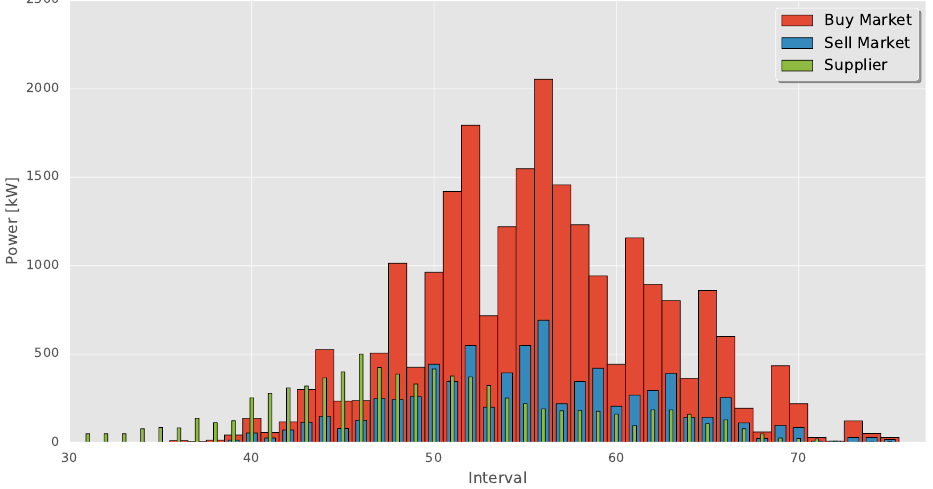
Figure 5. Energy market transactions and power purchased from the energy supplier in the main scenario for the different delivery intervals of the day averaged over 35 days with a lead time of 2 intervals, a trading unit of 100kW and 100